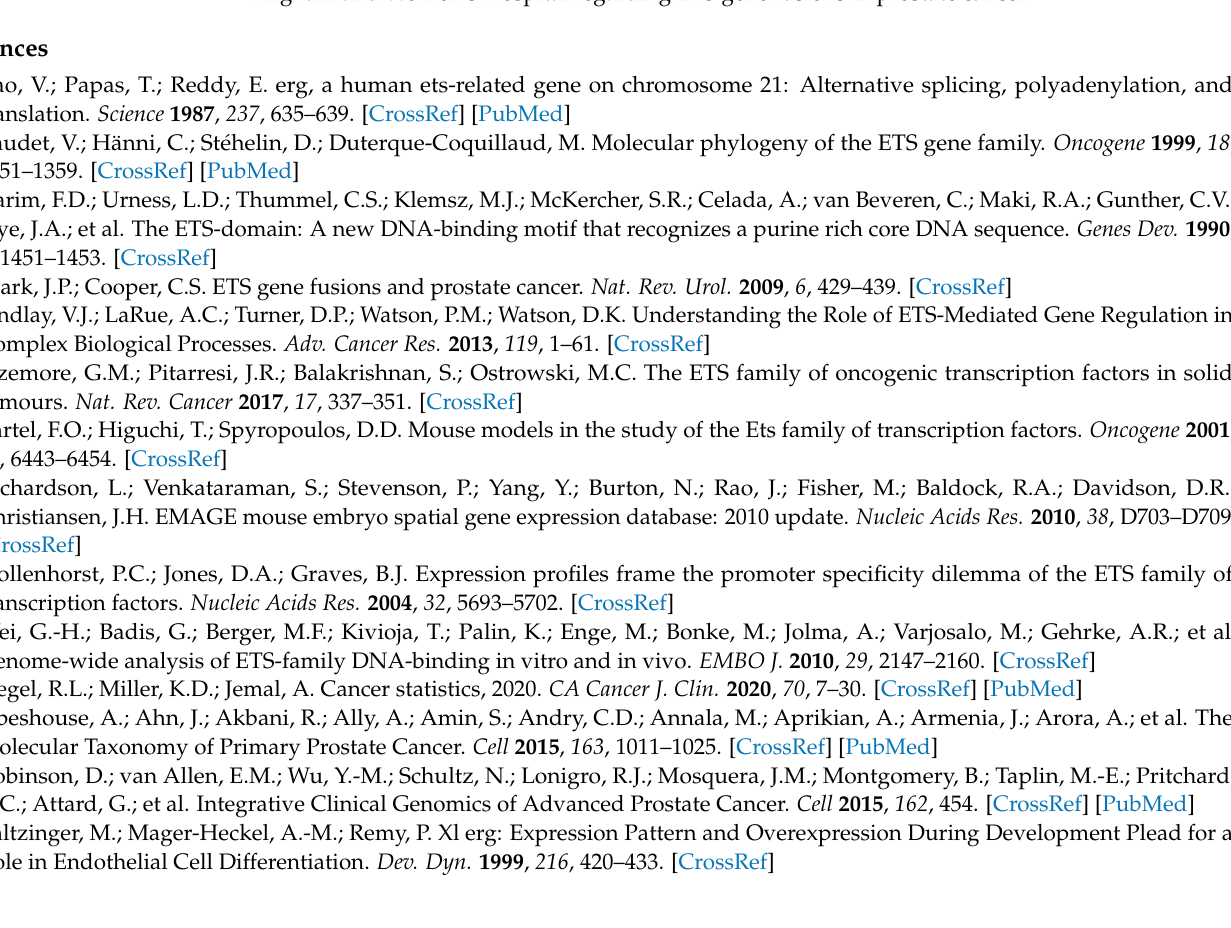
Figure 2 and Giulia Fracassi and members of the Demichelis’ laboratory for fruitful feedback on the